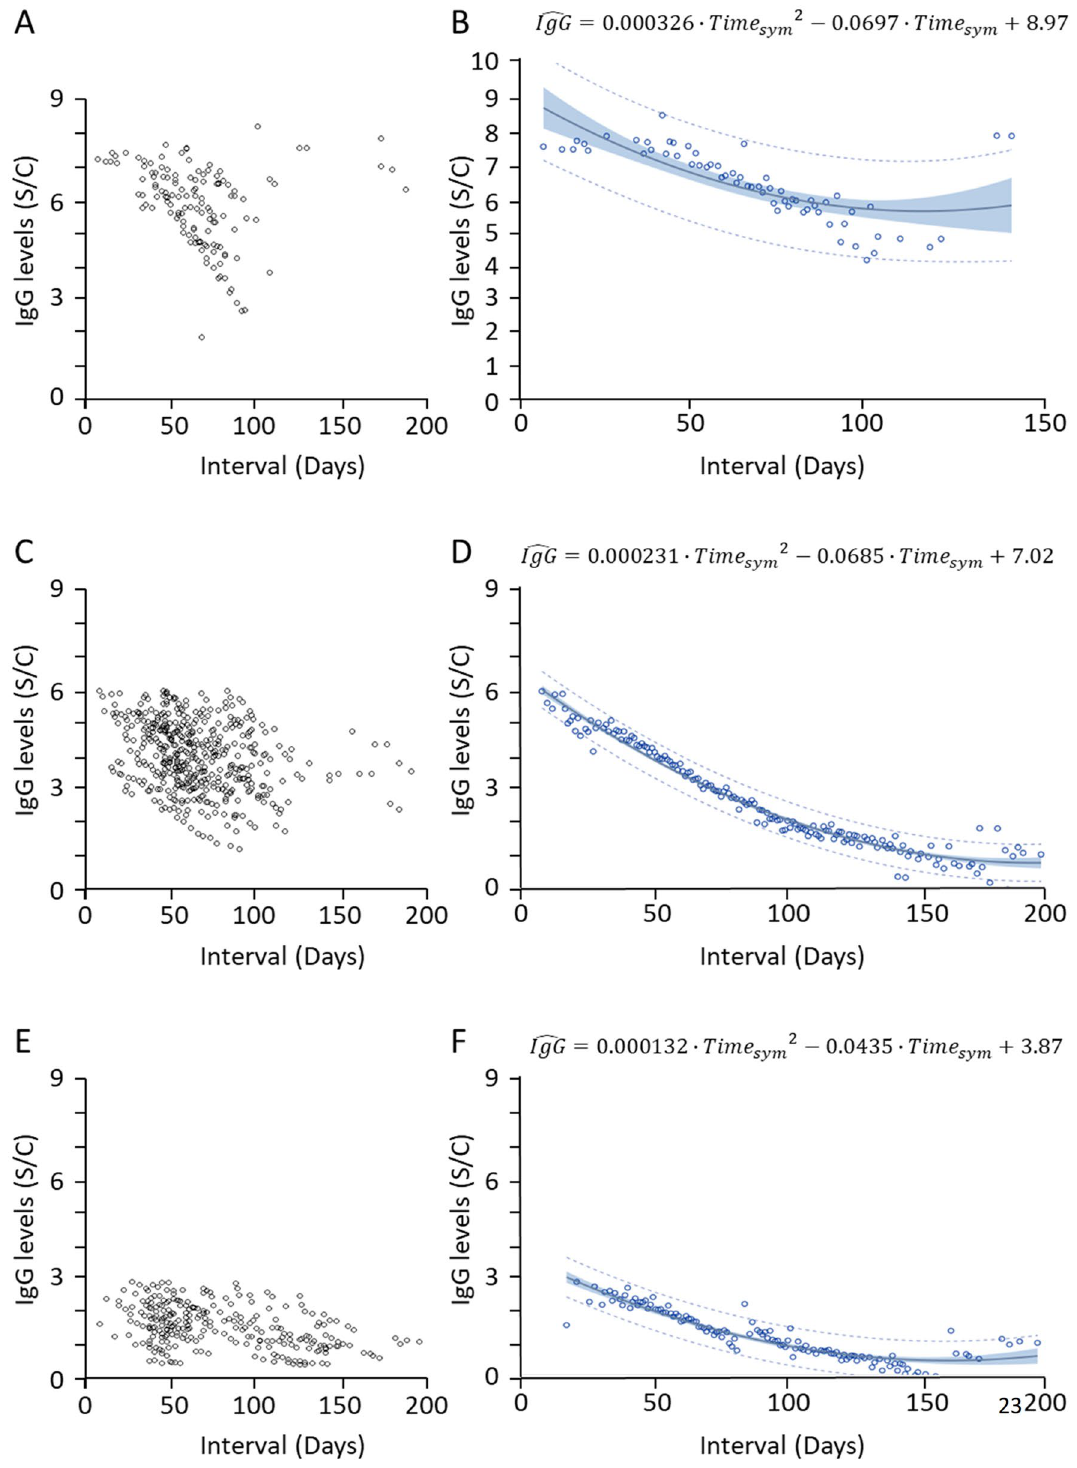
Figure 3. Antibody decay rates in subjects with variable anti-N IgG levels. ( A ) Distribution of anti-N IgG levels from subjects whose first donation of blood carried high levels of IgG (above 6 S/C). ( B ) Estimated mean anti-N IgG levels at each time point from the mixed model estimation. ( C ) Distribution of anti-N IgG levels from subjects whose first donation of blood carried medium levels of IgG (between 3 and 6 S/C). ( D ) Estimated mean anti-N IgG levels at each time point from the mixed model estimation. ( E ) Distribution of anti-N IgG levels from subjects whose first donation of blood carried low levels of IgG (below 3 S/C). ( F ) Estimated mean anti-N IgG levels at each time point from the mixed model estimation. Each dot represents the estimated IgG level at that time point. In ( B , D , F ) the solid curve line is the estimated fitting model. The blue shaded band shows the 95% confidence interval for the IgG level, and the dashed band shows the 95% prediction interval for the IgG level with this